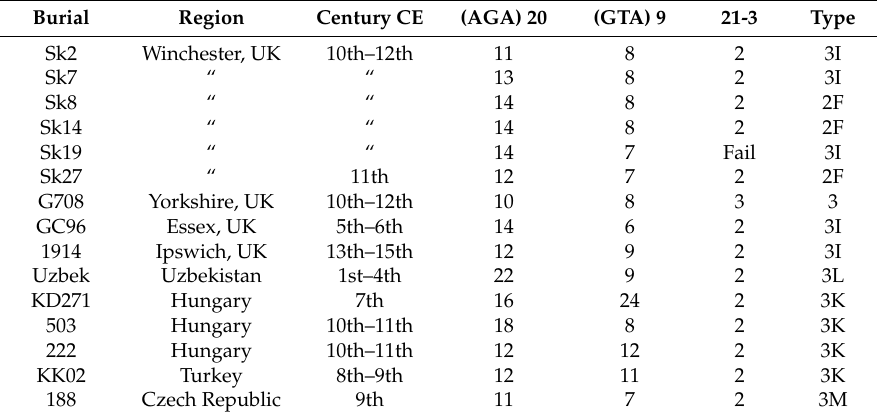
Table 3. Variable number short tandem repeats (VNTR) Sub-genotyping of M. leprae aDNA.